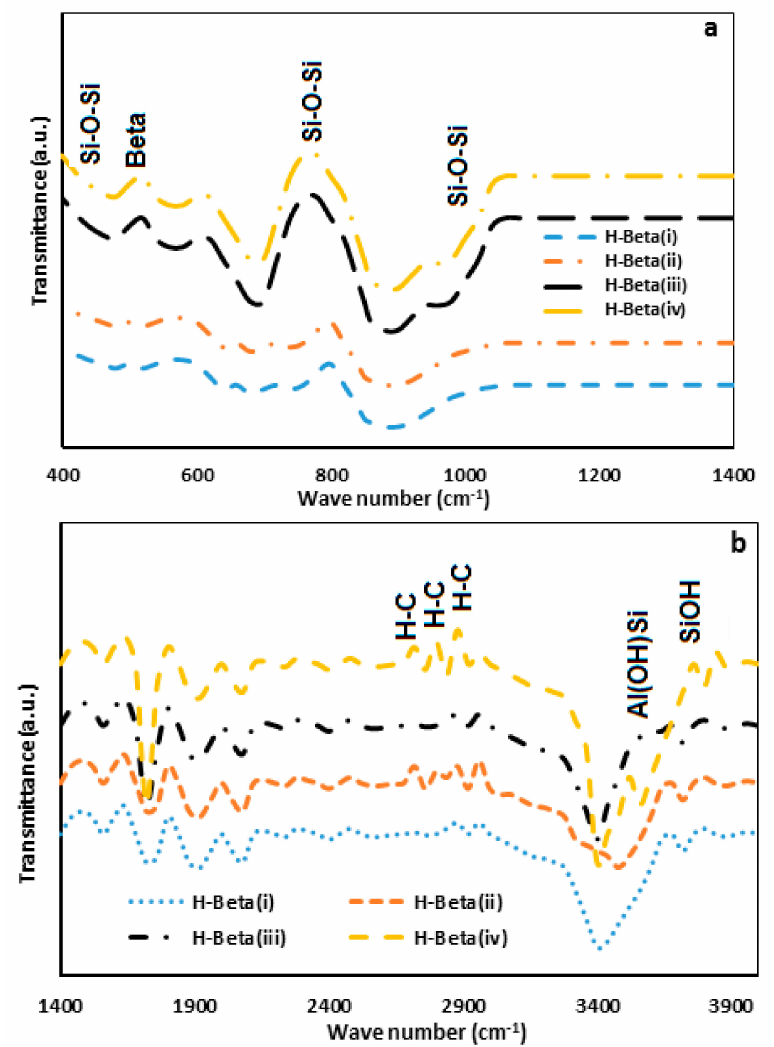
Figure 6. Fourier–transform infrared (FTIR) spectra of the Beta-zeolite in the region ( a ) 400–1400 cm − 1 and ( b ) 1400–4000 cm − 1